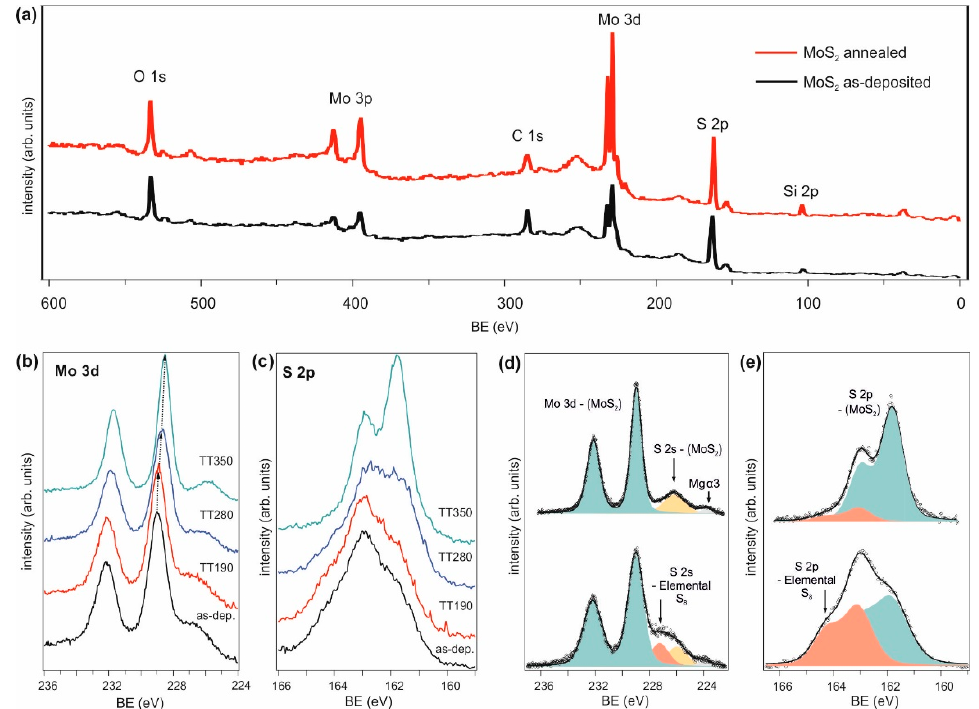
Figure 2. IJD-MoS 2 thin film deposited at 15 kV acceleration voltage: ( a ) XPS survey of as-deposited and annealed (T = 350 °C) thin film; ( b ) Mo 3d–S 2s and ( c ) S 2p core level spectra of as-deposited thin film and corresponding sample annealed at different temperatures T = 190, 280, 350 °C; deconvolved ( d ) Mo 3d–S 2s and ( e ) S 2p core level spectra of as-deposited and annealed (T = 350 °C) thin film.